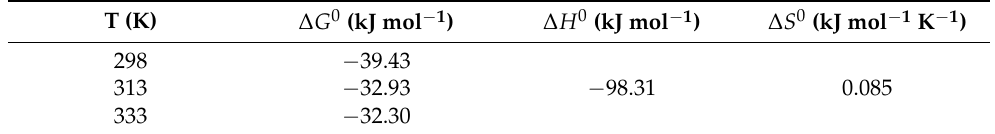
Table 6. Parameters of the adsorption thermodynamics at 298, 313, and 333 K.